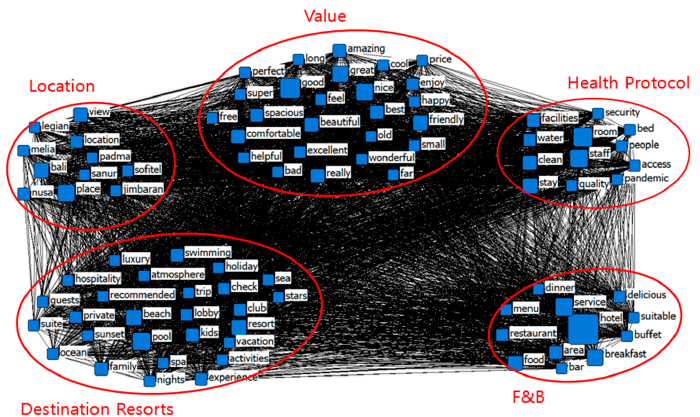
Figure 2. Keyword visualization of network analysis generated by UCINET 6.0.